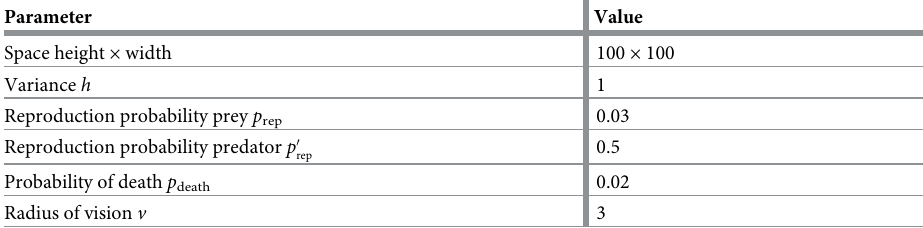
Table 2. Parameters used during the simulation of the